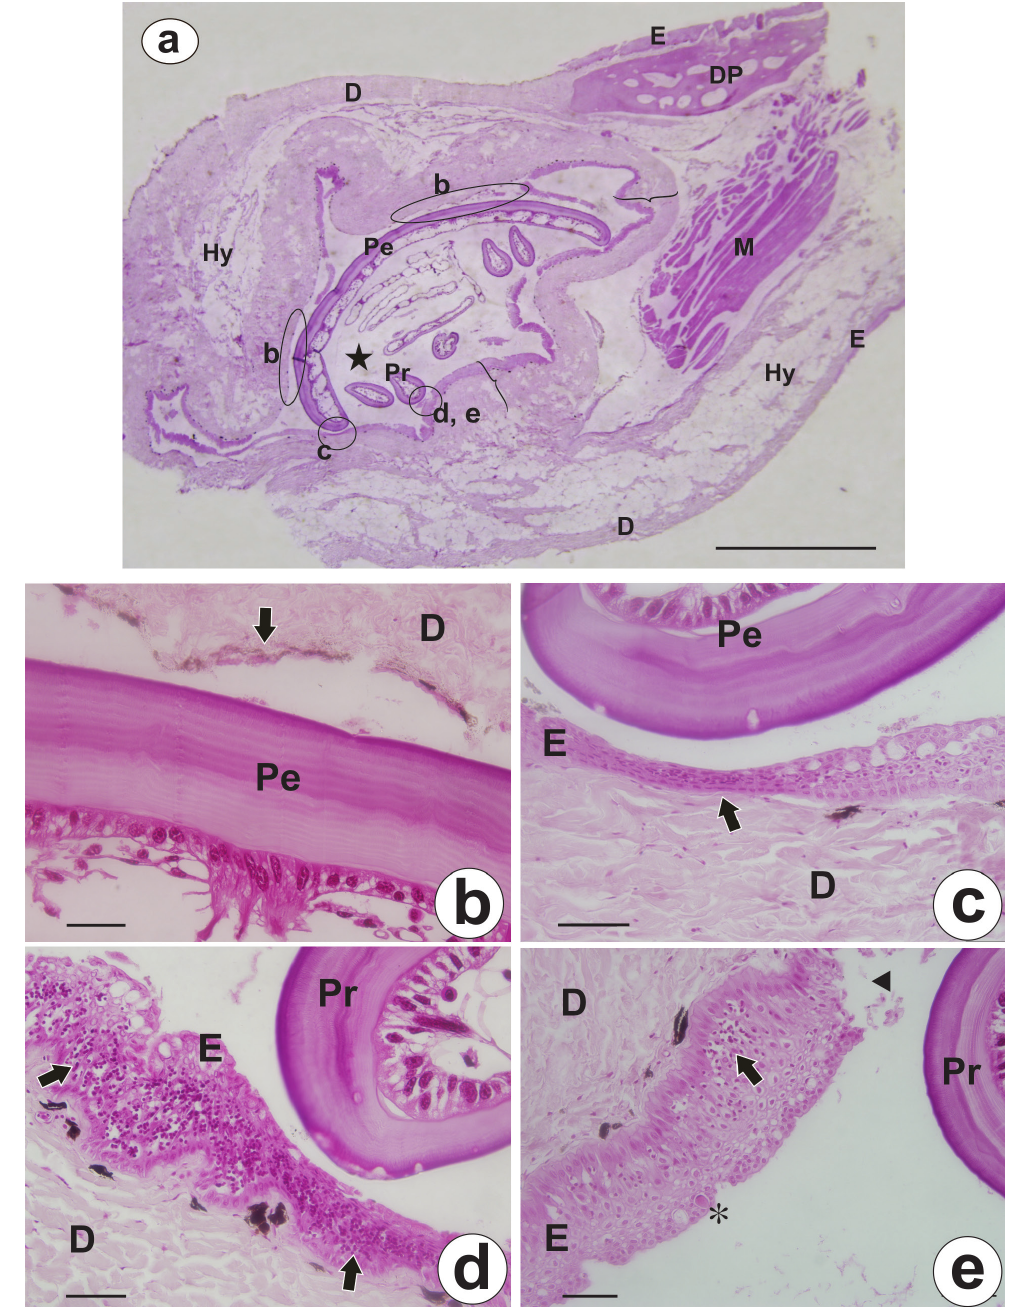
Figure 3 - a. Cross section at pore level showing the pouch, formed by epidermis and dermis (curly brackets), and inside the parasitic isopod (star), the circles (b - e) show the friction sites of the parasite. Scale bar: 2 mm. b – e. Detail of the friction sites. b. Dorsal region of the isopod, at pereonites level, pouch epidermal tissue is absent (arrow) and a decrease in the number of melanophores is observed. c. End of the pereonite, atrophy of the pouch epidermis was observed (arrow). d. e. At pereopods level, an increase in the height of the pouch epithelium is observed and an intense cellular infiltration, mainly lymphocytes (arrows), a few eosinophilic granular cells (asterisk) and desquamation of the epidermal tissue (head arrow). Scale bar: 50 µm. D: